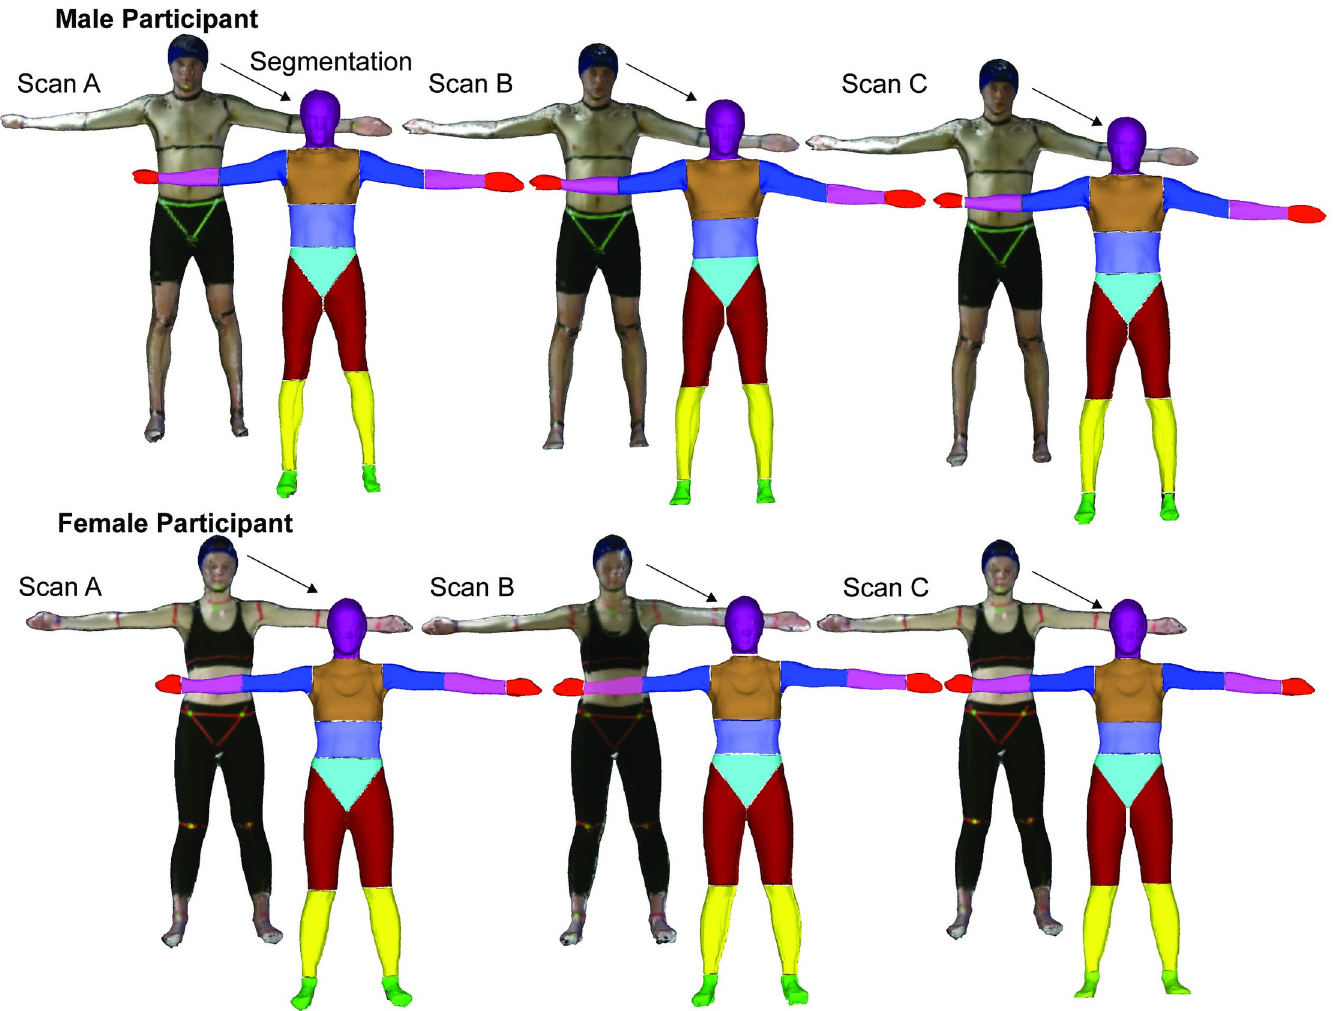
Fig 7. Three different scans (Scan A, Scan B, Scan C) and three individual body segmentations from a representative male and female participant are shown. The colouring used for the segmented scan is meant to show clear segmentation borders between adjacent body segments.